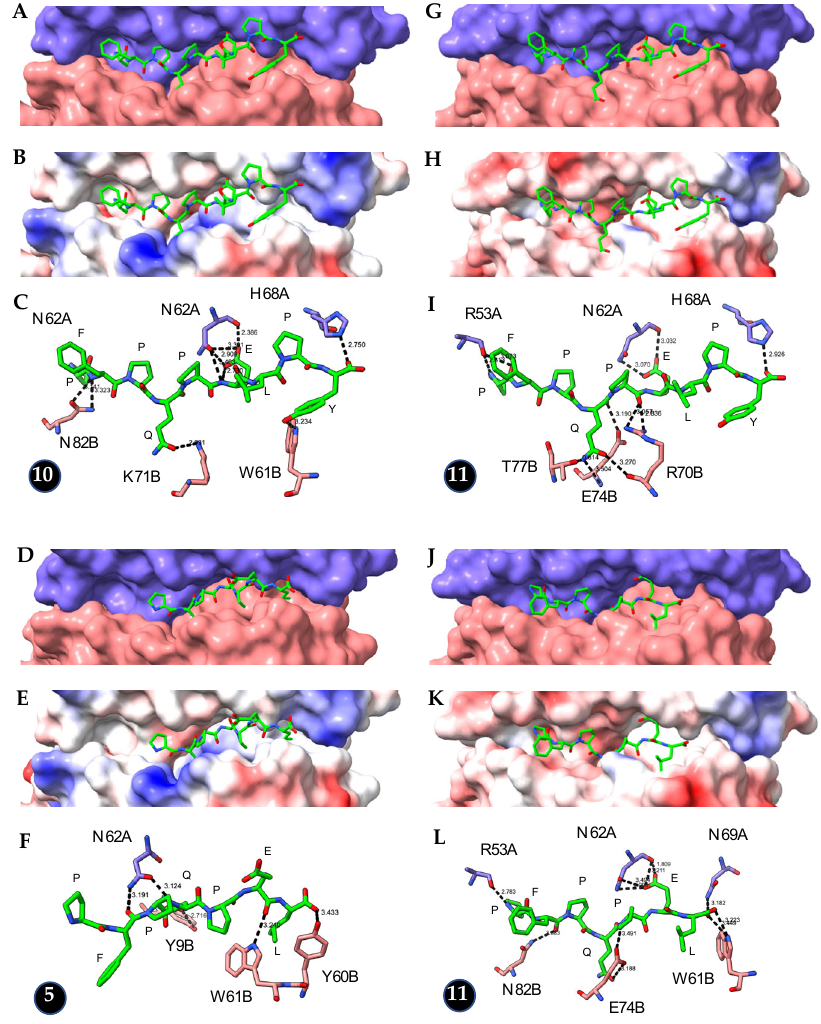
Figure 7. ( A – C ): ( A ). Docking of the DQ2 ‐ specific PFPQPELPY peptide (colored green) to the basket of HLA ‐ DQ2 (PDB code 1S9V). The A and B domains forming the HLA ‐ DQ2 basket are colored violet and pink, respectively. ( B ). Coulombic surfaces (acidic in red, basic in blue, neutral in white) of the basket. ( C ). Network of hydrogen bonds (dashed black lines) connecting the peptide to the amino acid residues of the A and B domains, labeled and colored violet and pink, respectively. ( D – F ): ( D ). Docking of the truncated PFPQPEL peptide (colored green) to the basket of HLA ‐ DQ2 (PDB code 1S9V). The A and B domains forming the HLA ‐ DQ2 basket are colored violet and pink, respec ‐ tively. ( E ). Coulombic surfaces (acidic in red, basic in blue, neutral in white) of the basket. ( F ). Net ‐ work of hydrogen bonds (dashed black lines) connecting the truncated peptide to the amino acid residues of the A and B domains, labeled and colored violet and pink, respectively. ( G – I ): ( G ). Dock ‐ ing of the DQ2 ‐ specific PFPQPELPY peptide (colored green) to the basket of HLA ‐ DQ8 (PDB code 4GG6). The A and B domains forming the HLA ‐ DQ8 basket are colored violet and pink, respec ‐ tively. ( B ). Coulombic surfaces (acidic in red, basic in blue, neutral in white) of the basket. ( C ). Net ‐ work of hydrogen bonds (dashed black lines) connecting the peptide to the amino acid residues of the A and B domains, labeled and colored violet and pink, respectively. ( J – L ): ( J ). Docking of the DQ2 ‐ specific truncated PFPQPEL peptide (colored green) to the basket of HLA ‐ DQ8 (PDB code 4GG6). The A and B domains forming the HLA ‐ DQ8 basket are colored violet and pink, respec ‐ tively. ( B ). Coulombic surfaces (acidic in red, basic in blue, neutral in white) of the basket. ( C ). Net ‐ work of hydrogen bonds (dashed black lines) connecting the truncated peptide to the amino acid residues of the A and B domains, labeled and colored violet and pink, respectively.